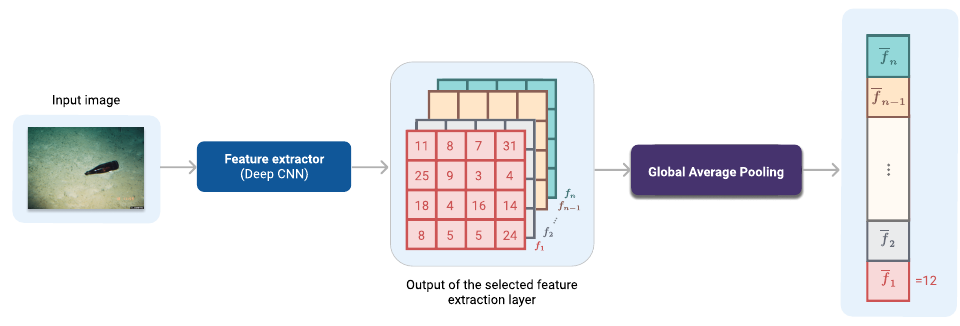
Figure 15. Extraction of dense feature